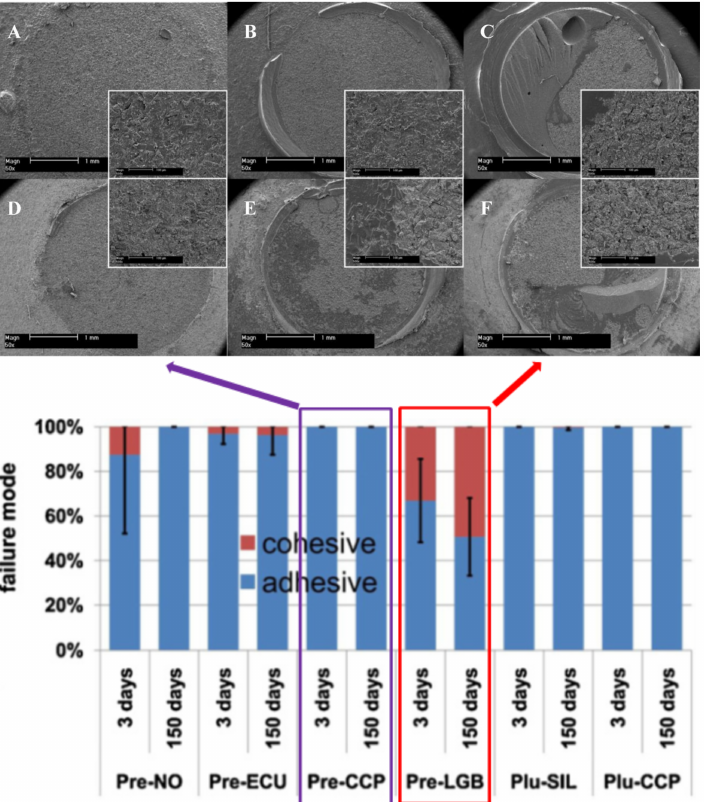
Figure 3. Above: SEM images of group samples measured after three days ( A – C ) and 150 days ( D – F ) with 50 × and 500 × magnifications. ( A , D ) depict spontaneously debonding, showing complete adhesive failure mode. ( B , E ) depict samples with medium tensile bond strength (TBS), showing residuals of primer. ( C , F ) depict samples with high TBS, showing residuals of primer and resin. In ( C , F ), a multifunctional resin varnish, including methacrylates as a conditioning layer, was applied to air-abraded PEEK surfaces. This conditioning layer demonstrated a long-lasting bond with the PEEK. Below: Failure modes of bonding groups. The figures were adopted and modified from the literature